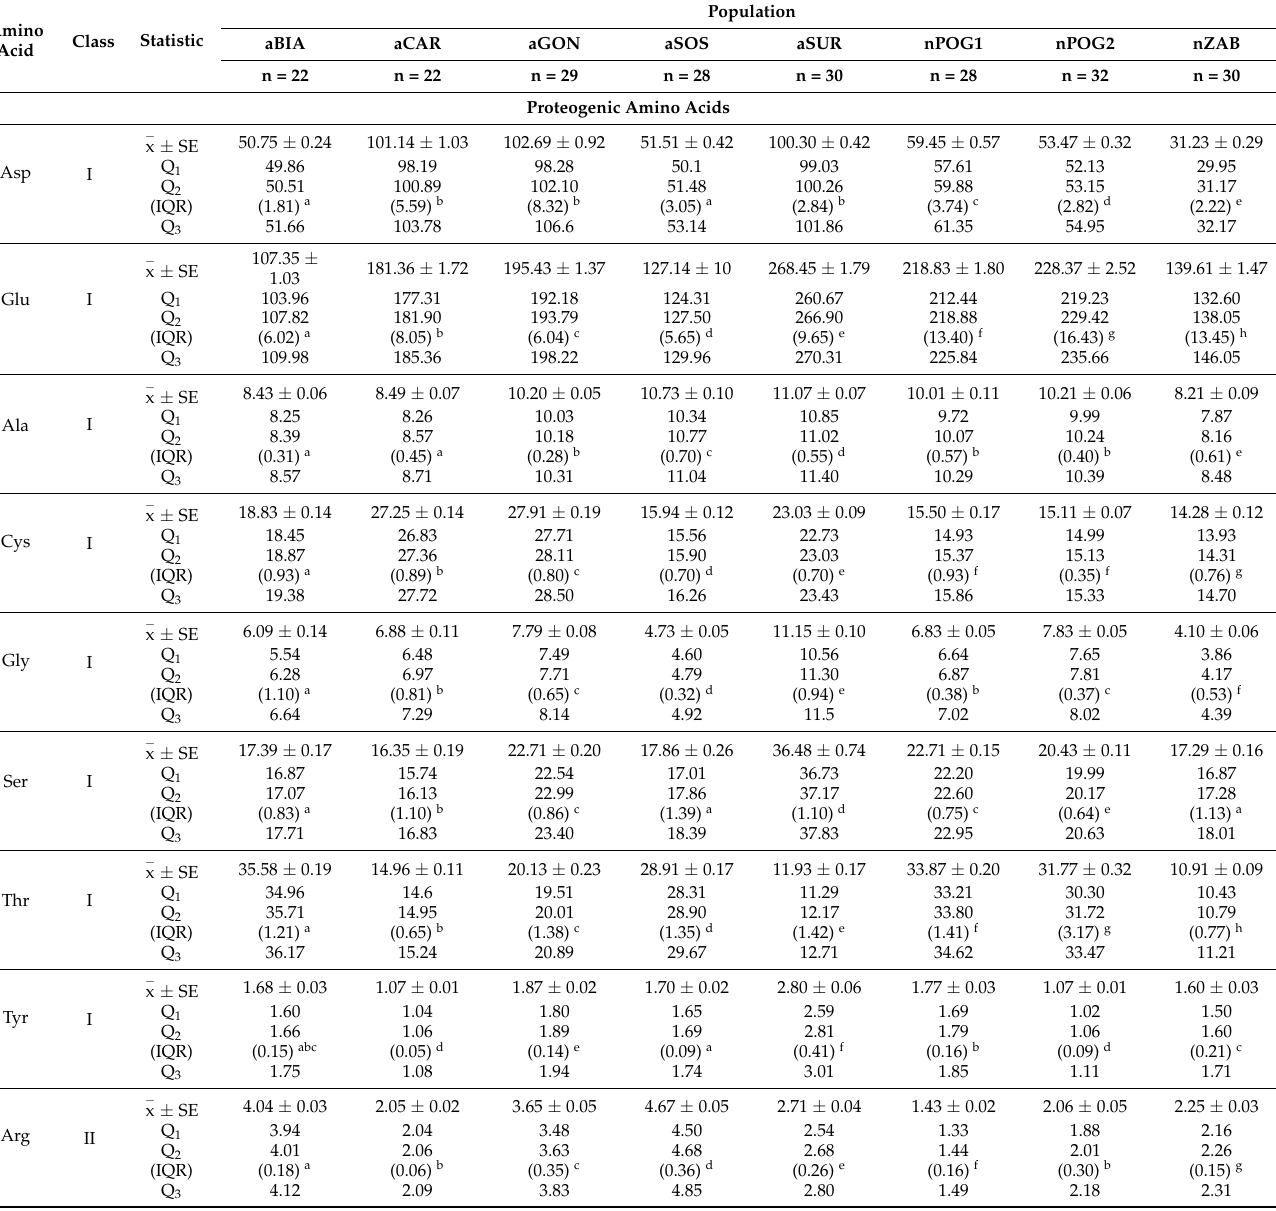
Table 4. Amino acid concentration ( µ M) in Epipactis helleborine nectar. The number of classes repre- sents the effect of amino acids on insect chemoreceptors: I, no effect; II, inhibition of chemoreceptors; III, stimulation of the salt cell; IV, the ability to stimulate the sugar cell. Data represent the mean (x) ± standard error (SE), lower quartile (Q 1 ), median (Q 2 ), upper quartile (Q 3 ), interquartile range (IQR), and biological replicate (n). Different letters indicate statistically significant differences accord- ing to the pairwise Wilcoxon rank sum test with the Benjamini–Hochberg adjustment ( p <